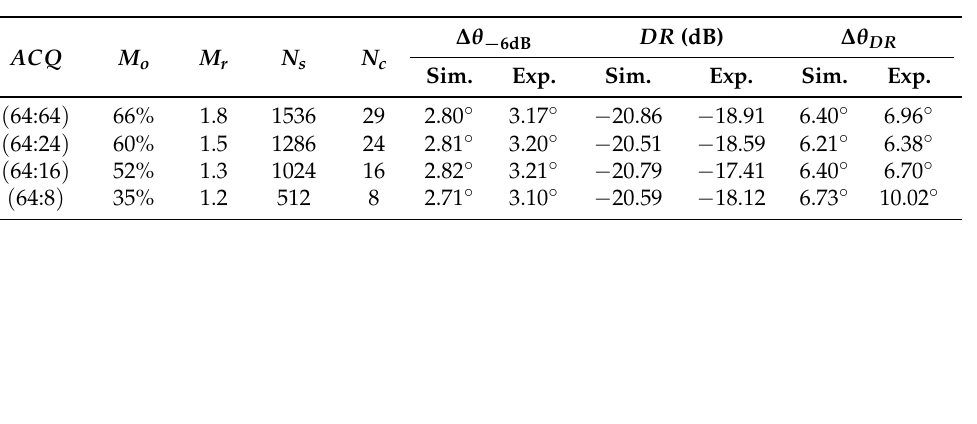
Table 2. Segmented Annular Array. Performance for ( 64:64 ) , ( 64:24 ) , ( 64:16 ) and ( 64:8 ) . Simulated and experimental data included for ∆ θ − 6 dB , DR (dB) and ∆ θ DR